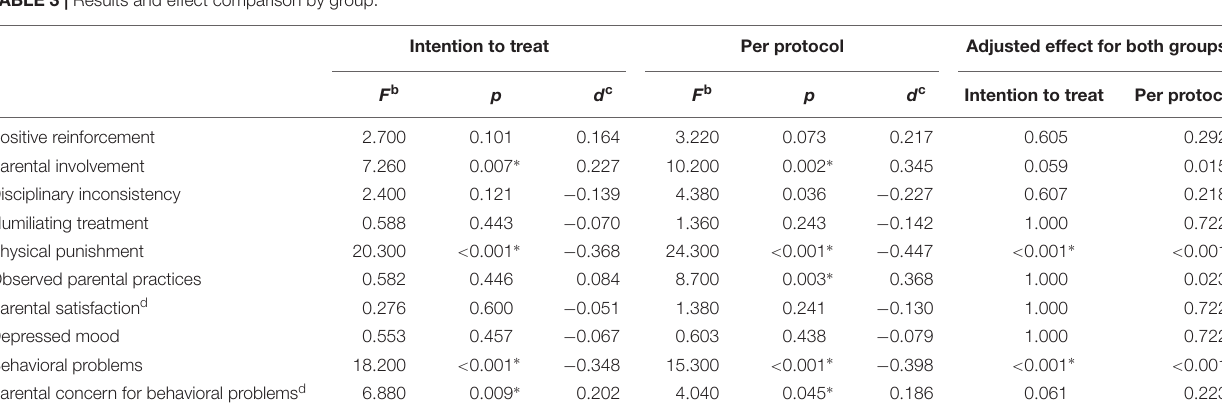
TABLE 3 | Results and effect comparison by